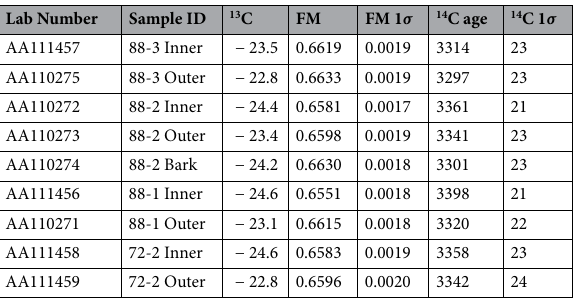
Table 1. Radiocarbon ages ( 14 C years BP) for four stem samples taken from the Therasia olive shrub.